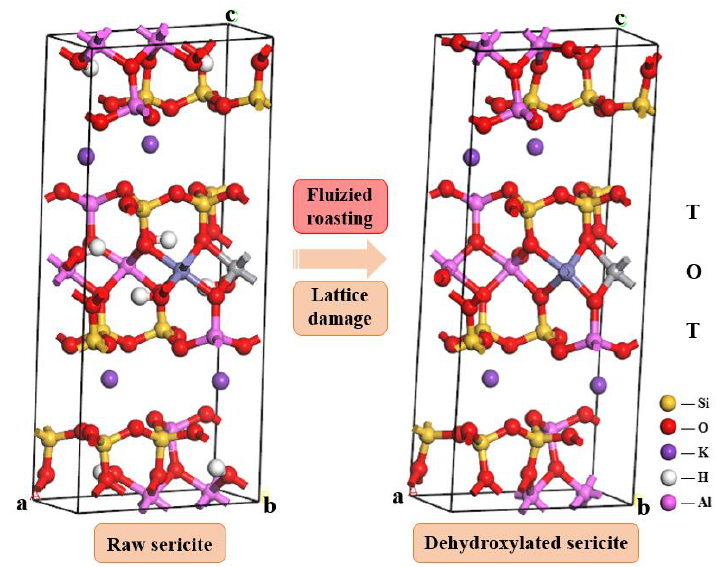
Figure 9. The crystal structure of sericite before and after dehydroxylation.